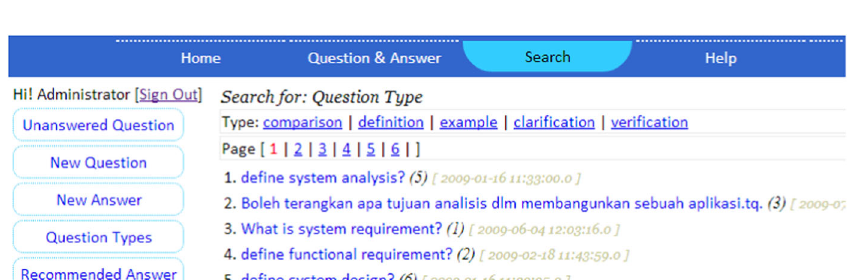
Figure 10. Example of concept map diagram